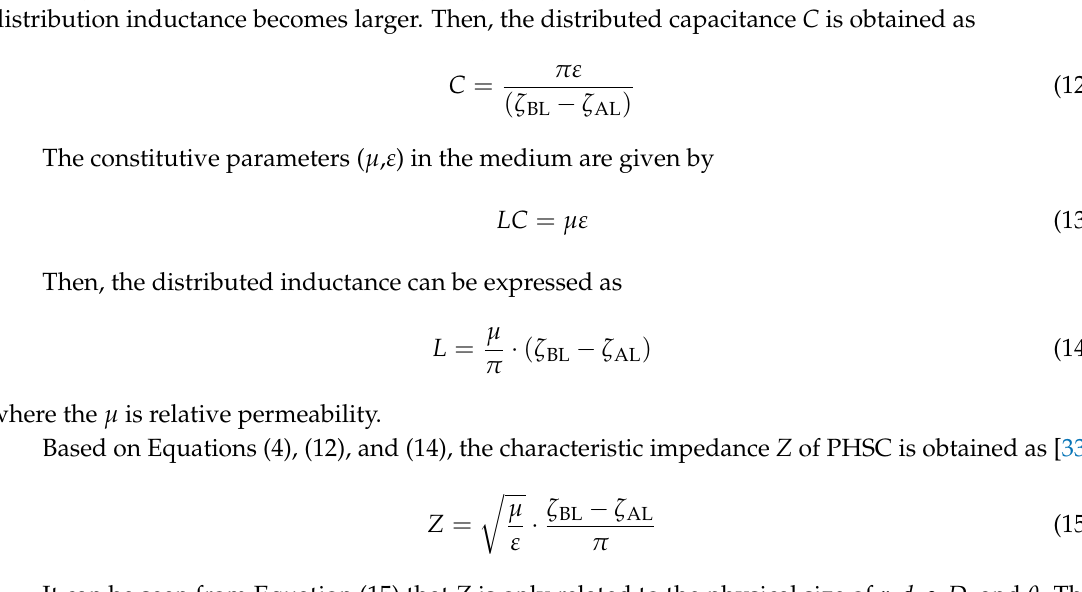
Figure 6. The calculated characteristic impedance Z of the four types of PHSC.